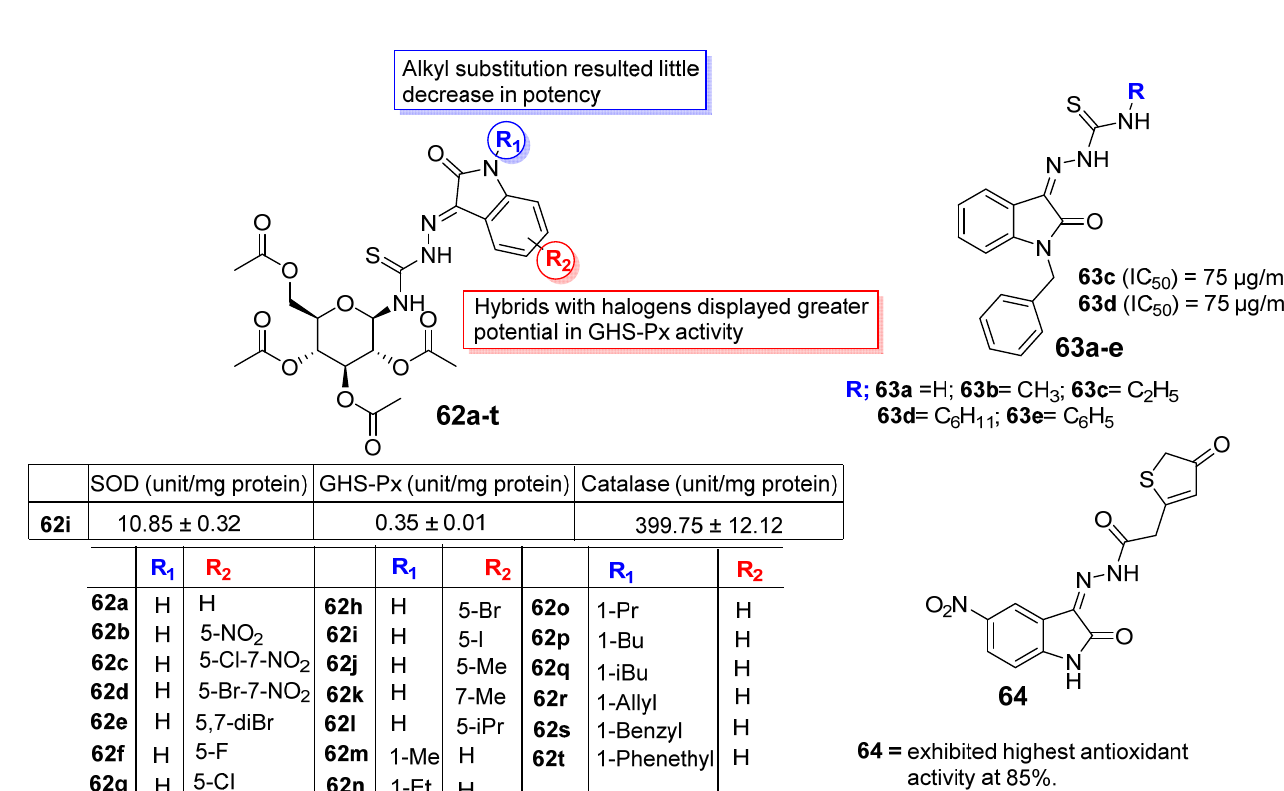
Figure 7. SAR features suggesting antioxidant activity of isatin derivatives.